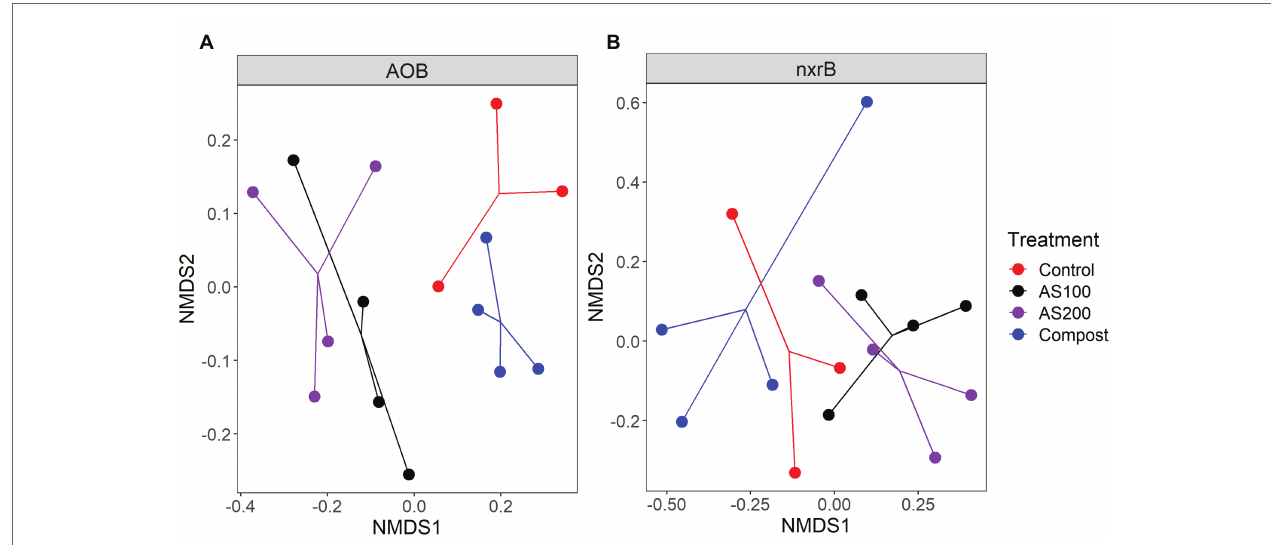
FIGURE 3 | NNMDS ordination based on the Bray-Curtis distance matrices showing the change in AOB (A) and Nitrospira (B) community composition for four N